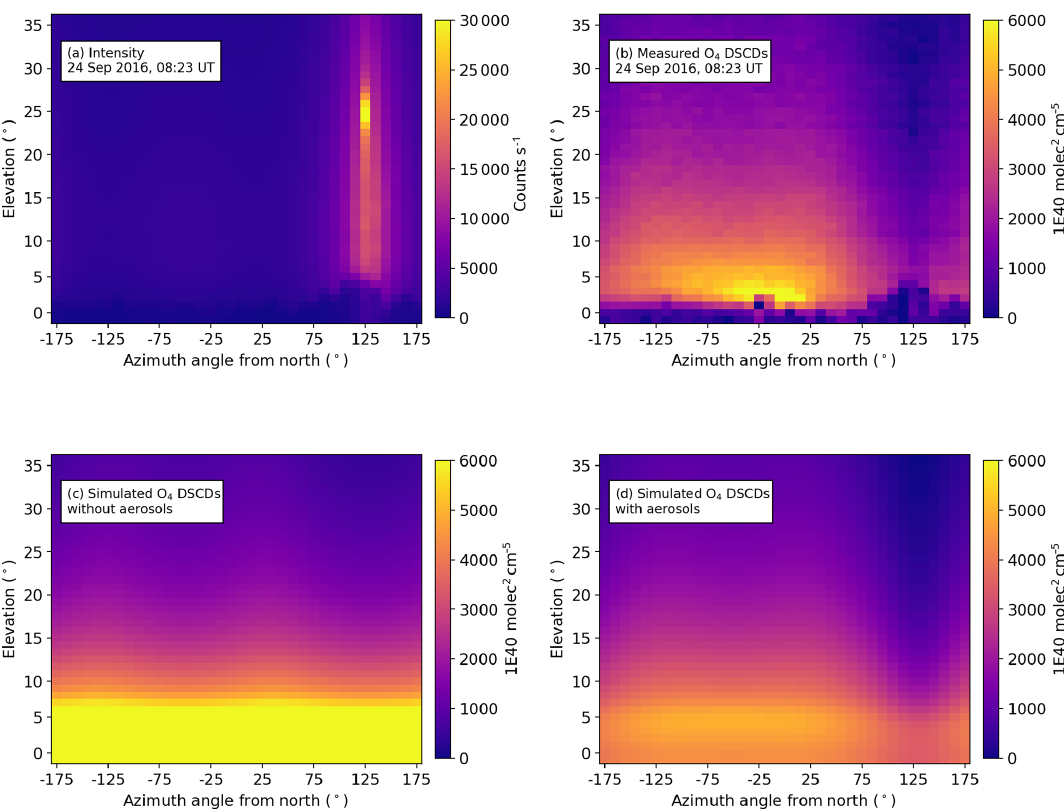
Figure 15. Intensity (a) and measured O 4 DSCDs (b) from one IMPACT panoramic scan on 24 September 2016, at 08:23UTC mean acquisition time, in comparison to simulated O 4 DSCDs without (c) and with aerosols (d) . Ground effects (obstacles discussed in Sect. 4.2) are of course not present in the